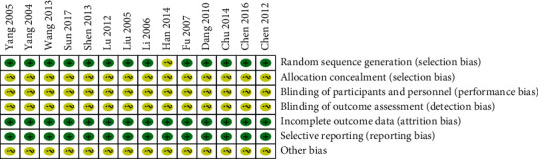
Risk of bias of included studies.